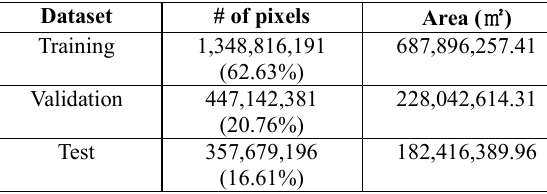
Table 1. Number of pixels and area of training, validation and test dataset